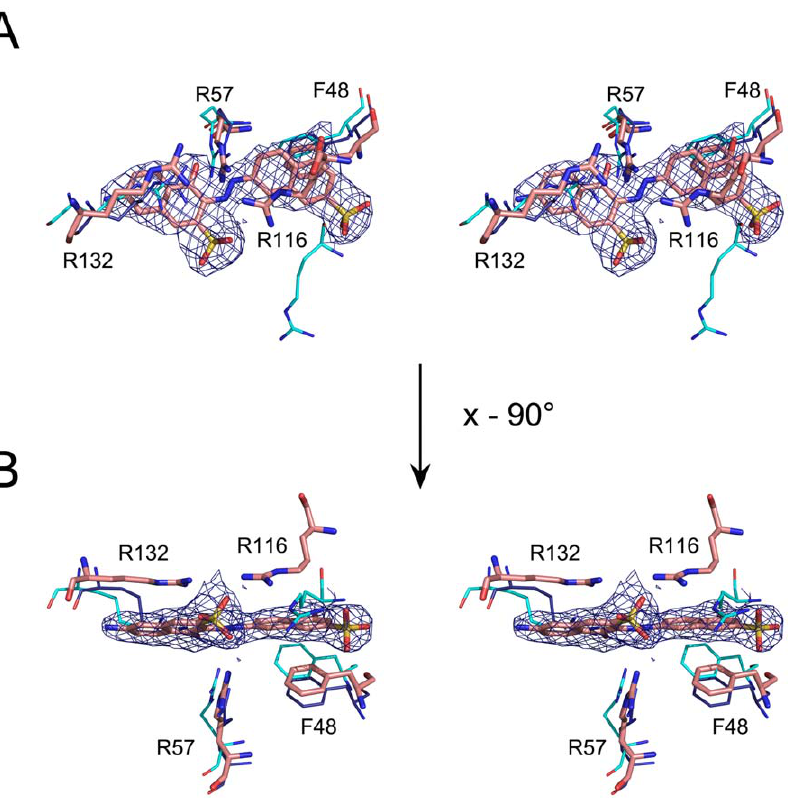
Figure 3. Stereoview of the electron density map of NSC162535. (B) is 90 degree rotation clockwise of (A). F48, R57, R116, and R132 are shown onto superimposed structures [E114A ? 162535 (pink), HpSK ? dimer ? SO 4 (blue), and HpSK ? S3P ? ADP (cyan)]. The 2 Fo 2 Fc electron density map shows the bound NSC162535, contoured at the 1.0- s level.